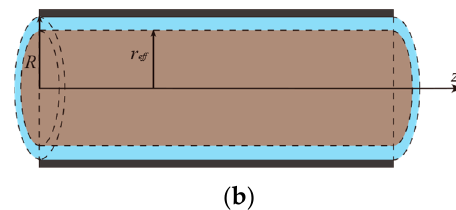
Figure 2. Schematic view of a large amount of small, dispersed droplets spread in a single capillary tube. ( a ) Dispersed droplets are uniformly spread on the axis of the cylinder; ( b ) the schematic view of the effective radius.